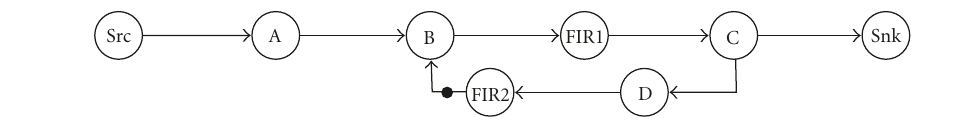
Figure 5: Implementation-unaware SRDF graph of a simplified channel equalizer.